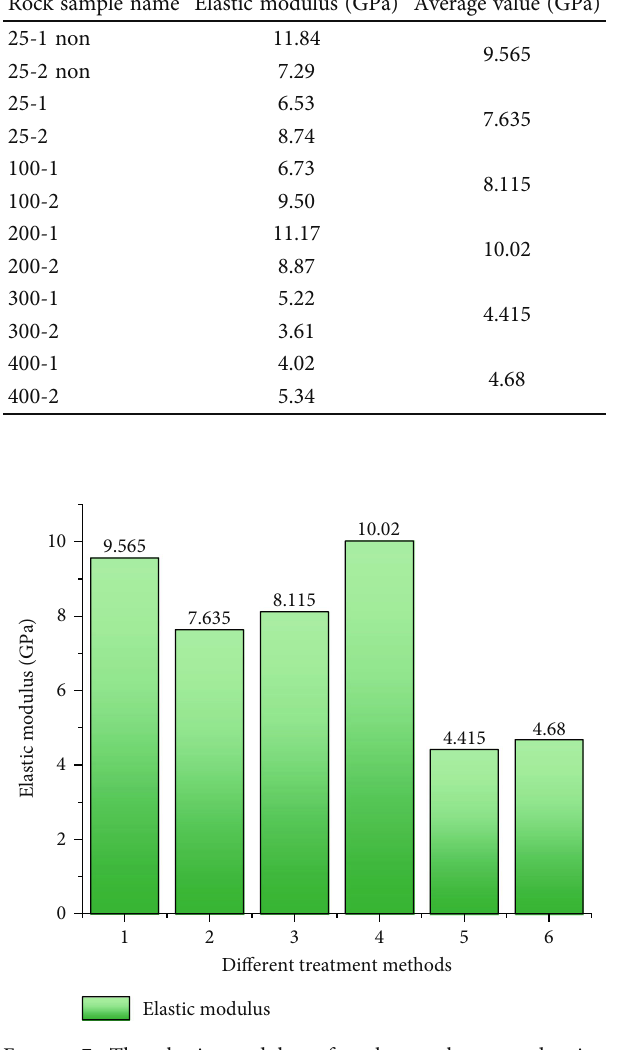
Figure 7: The elastic modulus of rock samples treated using various techniques.